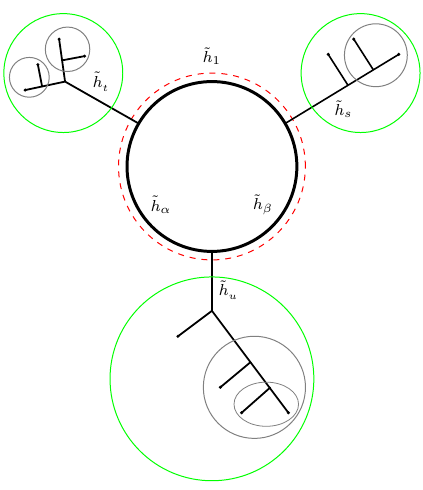
(2 , ch ) Figure 4 . The Casimir equations for n -point block ( q, z ) with a three-leg necklace sub-diagram. h, ˜ h,c F ( q, z ) with a three-leg necklace sub- Figure 4 . The Casimir equations for n -point block F (2 , ch ) The dashed line symbolizes three Casimir equations associated to the necklace sub-diagram. The green h, ˜ h,c diagram. The dashed red line symbolizes three Casimir equations associated to the necklace contours indicate three Casimir equations for three internal dimensions of three segments composing the necklace. Each green contour contains smaller contours which define Casimir equations for other sub-diagram. The green contours indicate three Casimir equations for three internal dimensions internal dimensions of planar sub-diagrams attached to the necklace. of three segments composing the necklace. Each green contour contains smaller grey contours which define Casimir equations for other internal dimensions of planar sub-diagrams attached to the